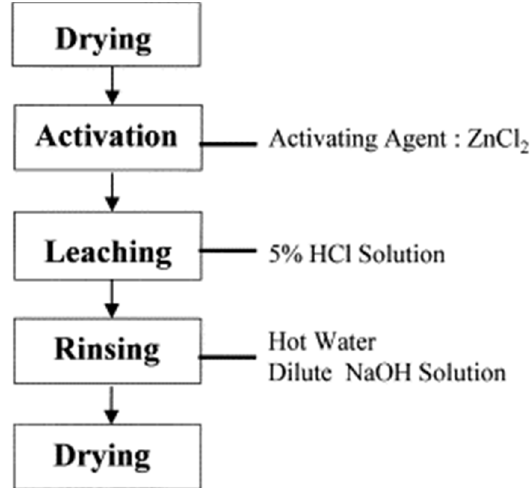
Figure 6. Flow chart for carbon activation process using ZnCl 2 . Reproduced with permission from [15], ©2001 Elsevier Science B.V.